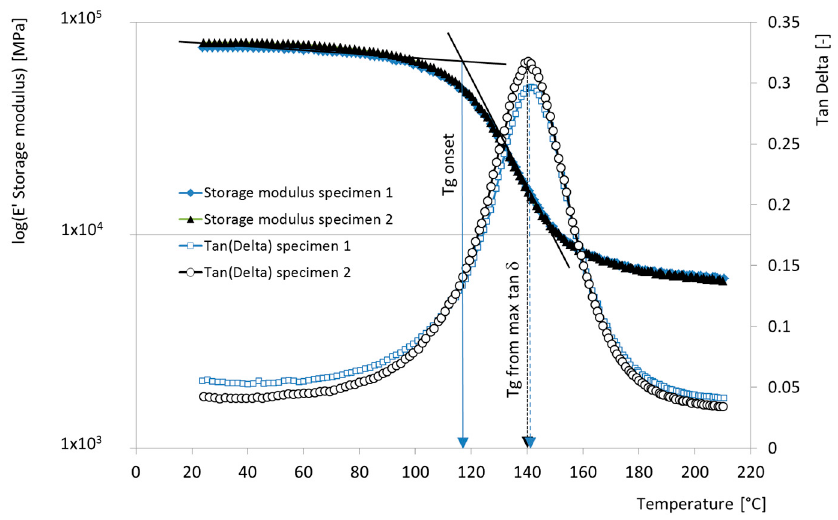
Figure 9. Results of DTMA analysis, E’ and tan δ versus temperature for the novel UHM CFRP tendons.